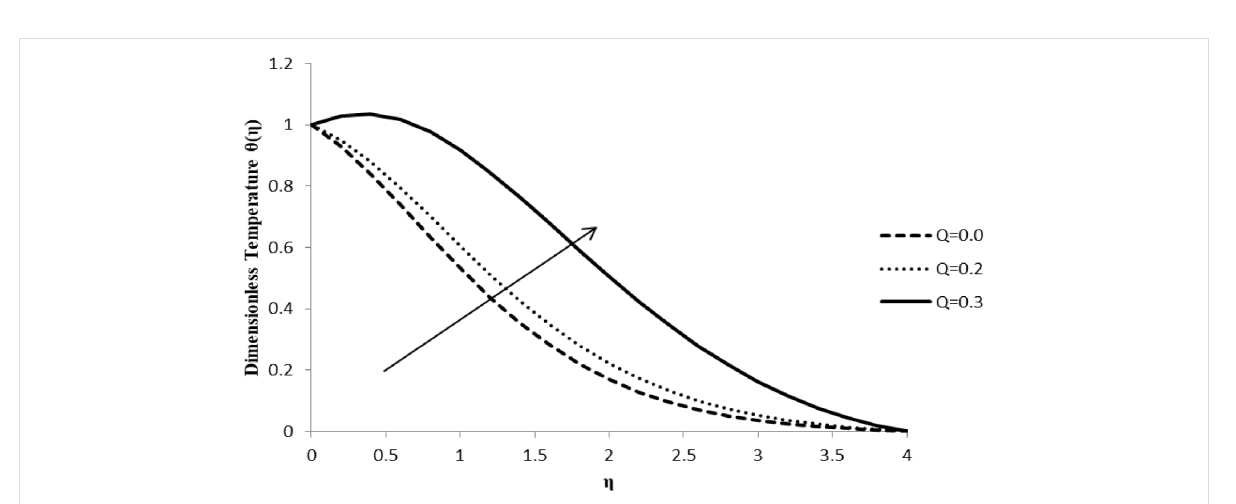
Figure 16: Influence of the heat generation/absorption coefficient Q on the temperature distribution θ ( η ) when n = 2.0, Pr = 2.0, Nb = Nt = 0.5, M = 0.0, Le = 5.0, F w = 0.2, and ξ =